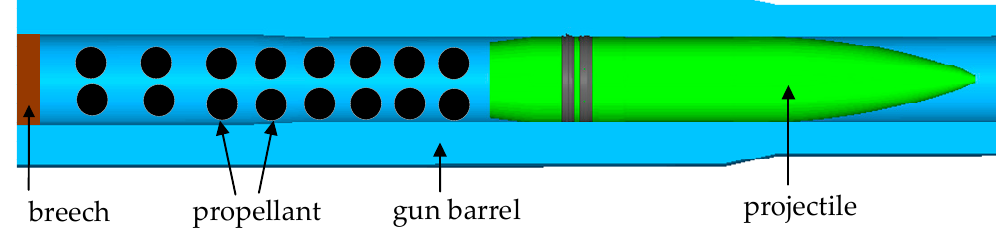
Figure 1. Schematic drawing of propellant location.